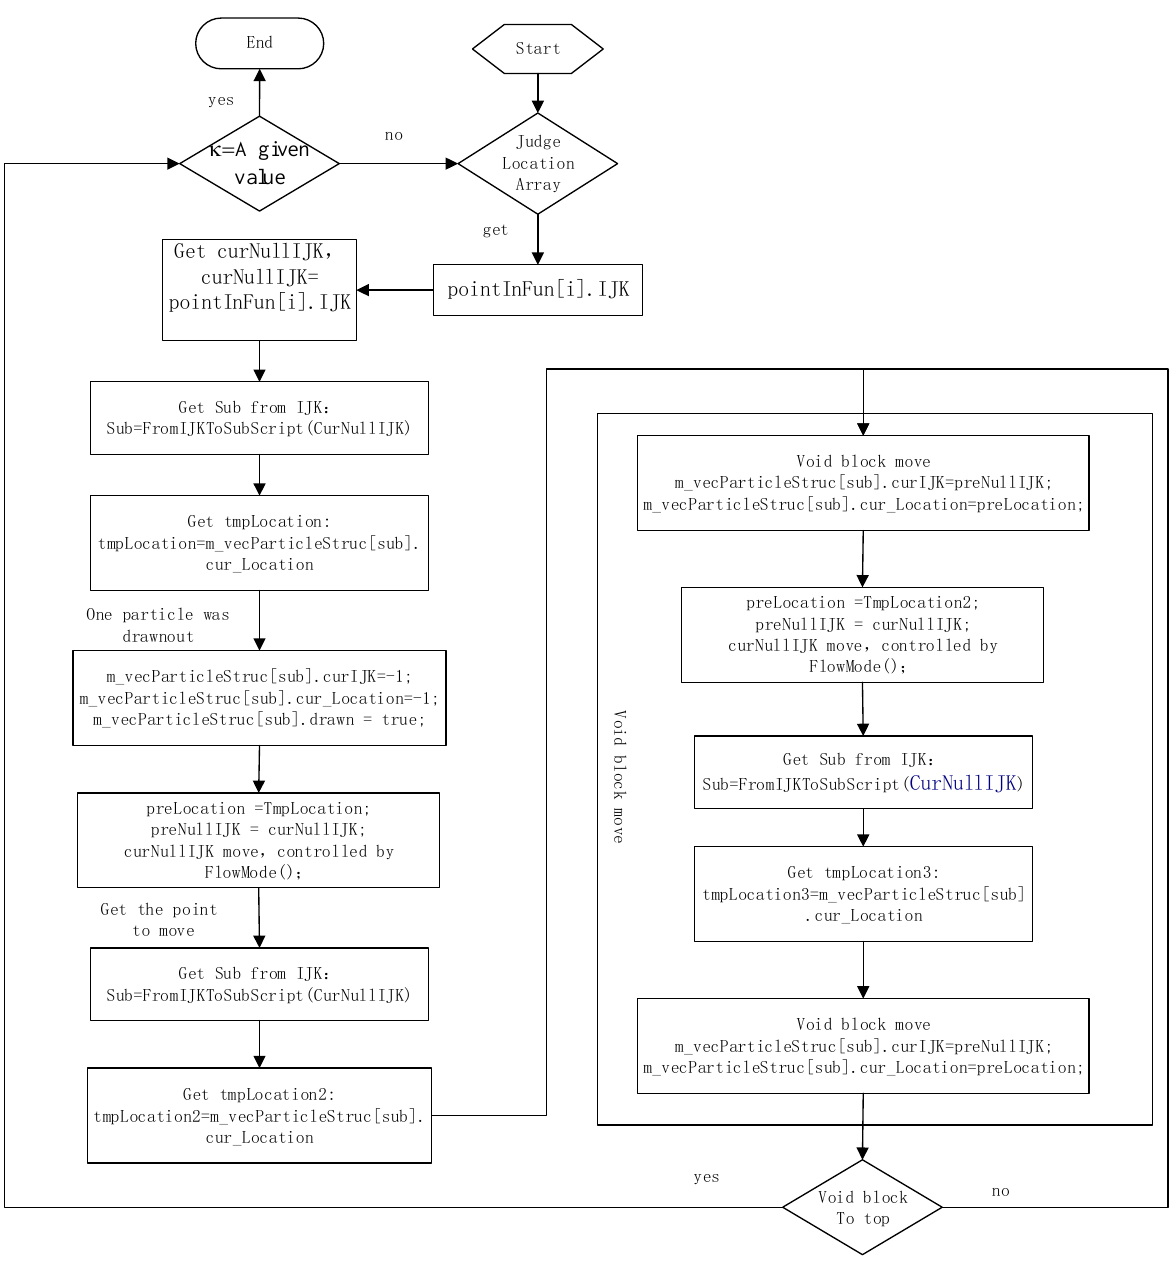
Figure 4. Flow chart of attribute blocks flow simulation.